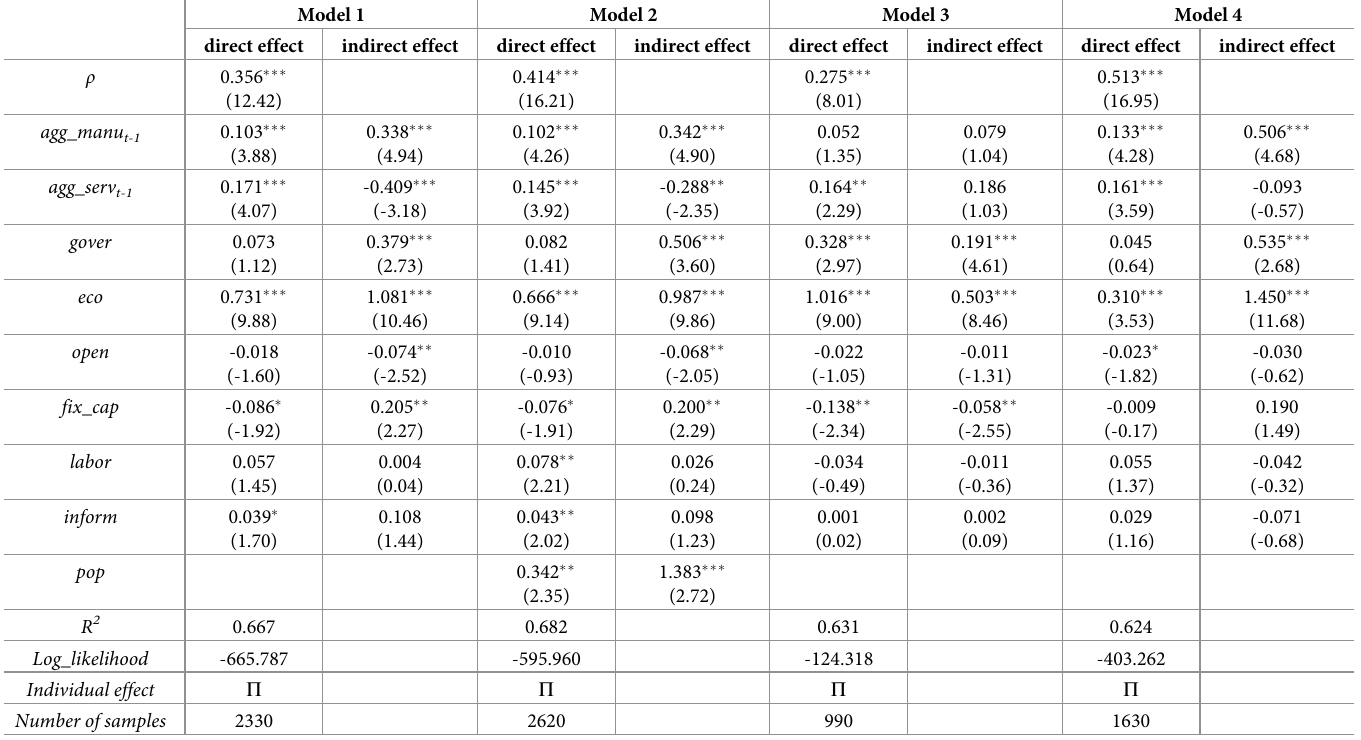
Table 8. Robustness check based on economic distance weight